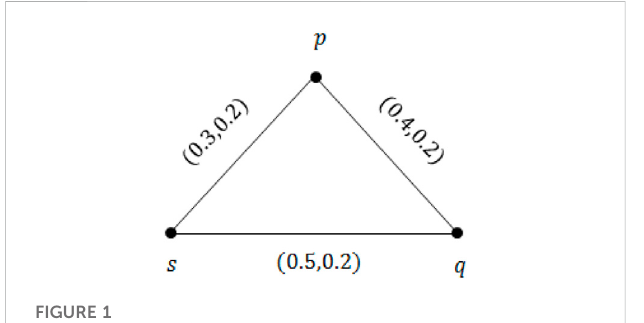
FIGURE 1 Vague edge graph ^ ζ (cid:1) ( V , N )